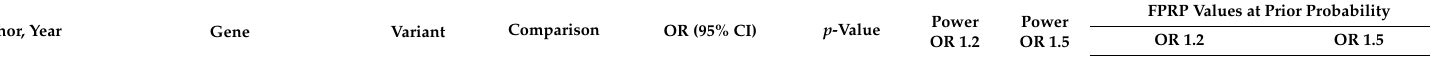
Table 3. Re-analysis results of gene variants with genome wide statistical significance ( p -value < 5 × 10 − 8 ) and borderline statistical significance (5 × 10 − 8 ≤ p -value < 0.05) in the genome-wide association studies (GWAS)